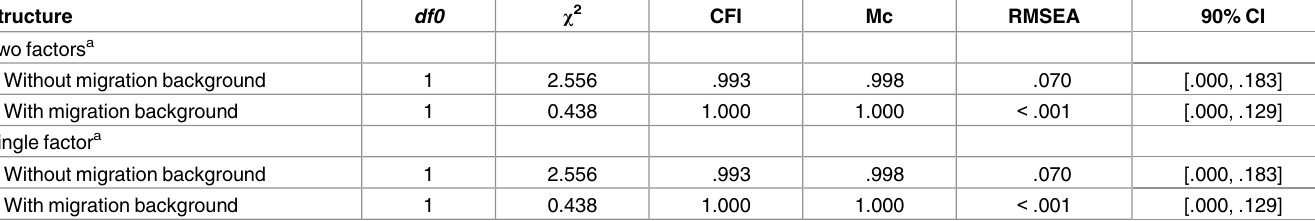
Note . N Without migration background = 316, N With migration background = 316. CFI = Comparative Fit Index; Mc = McDonald’s Noncentrality Index; RMSEA = root mean square error of approximation; CI = confidence interval.